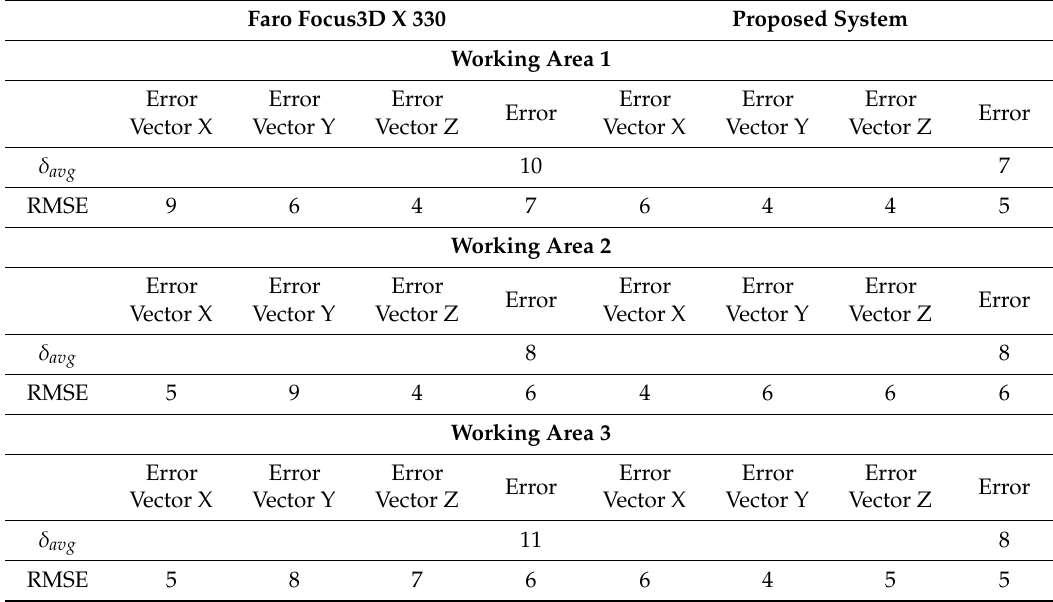
Table 4. Accuracy assessment result for the Faro Focus3D X 330 and proposed system in working areas 1, 2, and 3 (unit: